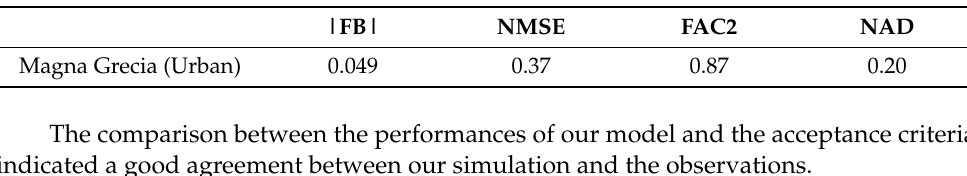
Figure 10. Regression plot of modelled vs. observed NOx hourly concentrations of the complete dataset ( a ) and of selected days 10 May ( b ), 16 May ( c ), 19 May ( d ) with a mean fractional bias lower than 20%. Table 5. Model performances at Magna